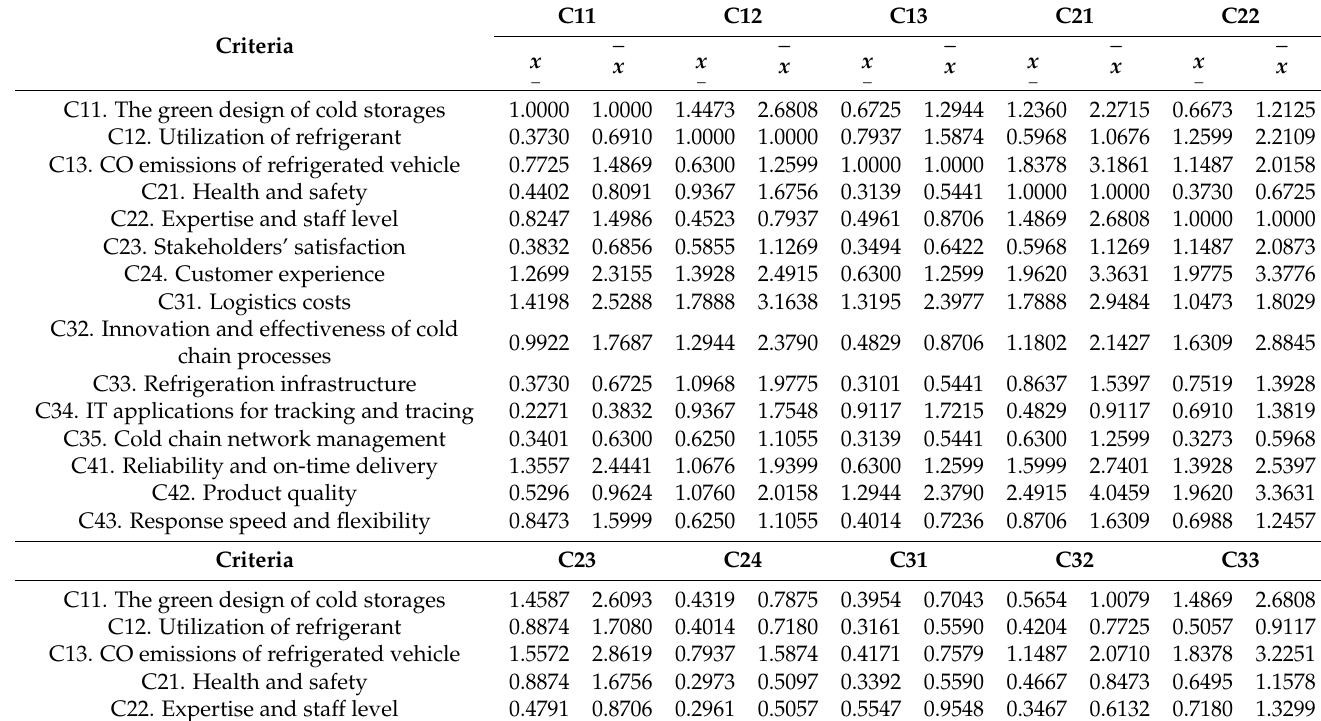
Table A1. The integrated grey comparison matrix of the